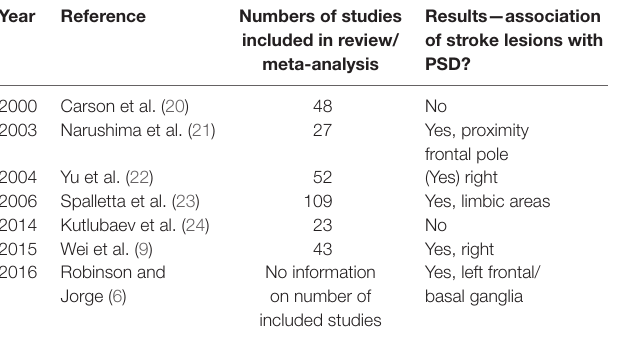
TAbLe 2 | Reviews on post-stroke depression (PSD) and lesion location and main